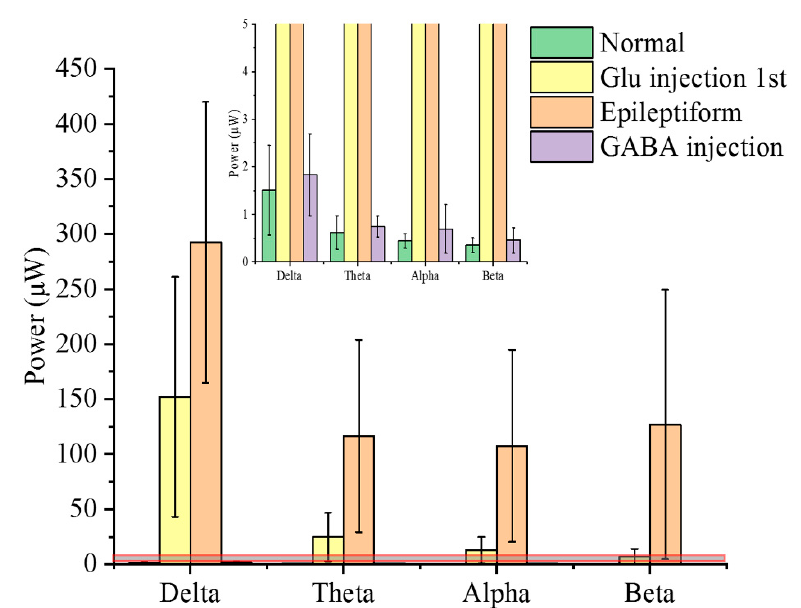
Figure 6. Power analysis in the frequency domain. The power of LFPs ( µ W) in multiple frequency bands (delta (1–4 Hz), theta (4–8 Hz), alpha (8–13 Hz), beta (13–30 Hz)) at different stages. The error bars represent standard deviation in power from three channels. An enlarged view of the gray area framed by the red line is shown at the top of the figure.